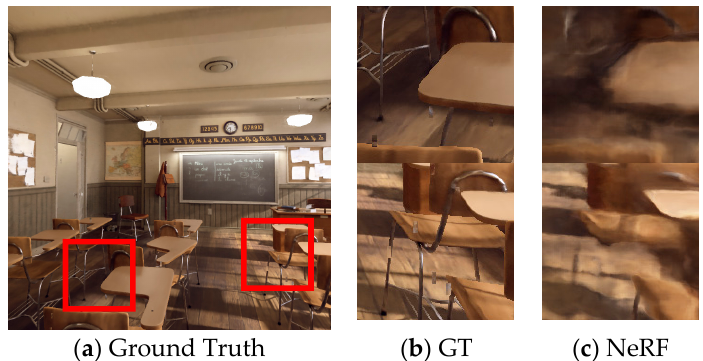
Figure 1. Local images of NeRF reconstruction effect on 11 images.